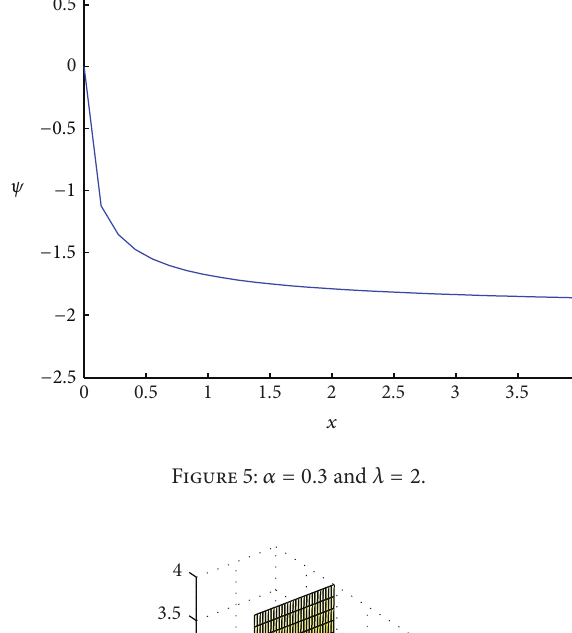
Figure 5: 𝛼 = 0.3 and 𝜆 = 2 .